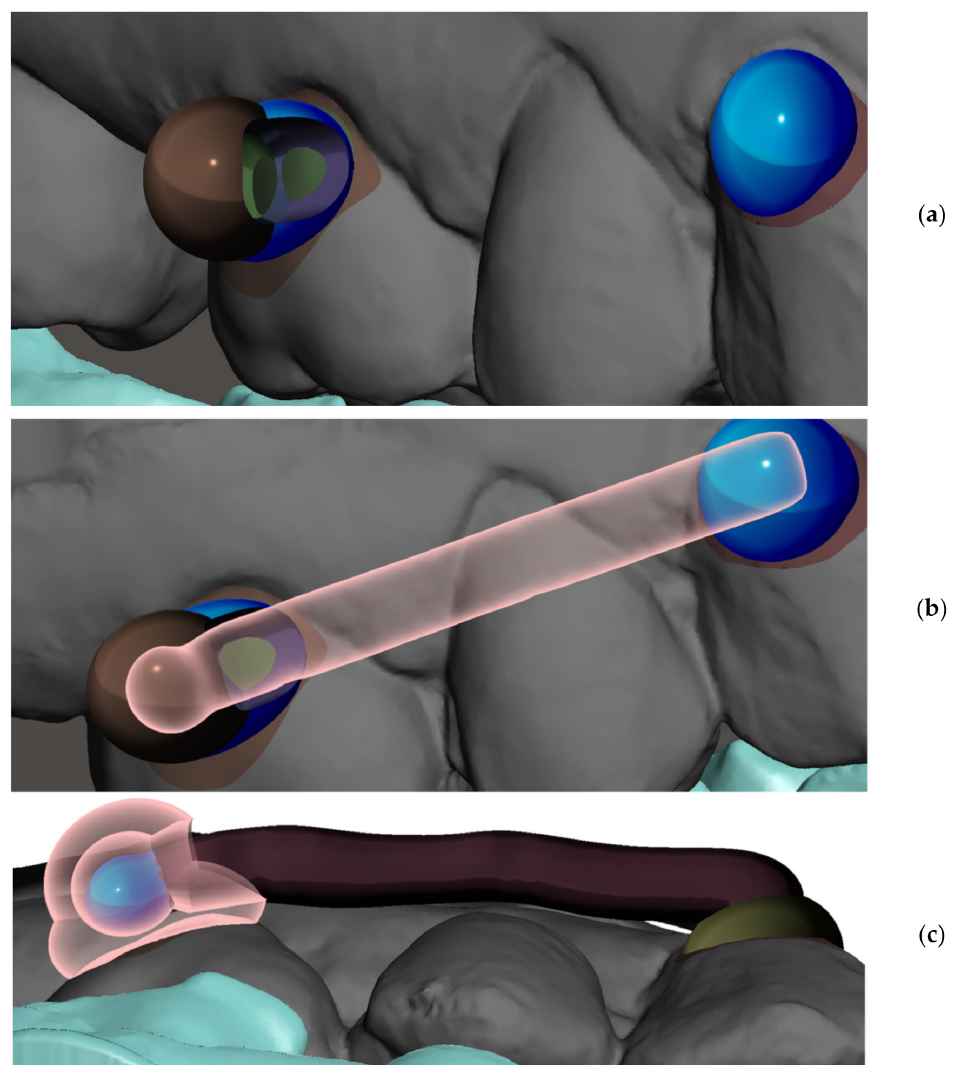
Figure 9. Visualization of the juncture of both parts of the distalizer (bigger part with the arm and joint and the smaller part with the socket). ( a ) visual of the molar part of the distalizer including the socket; ( b ) visualization of ending of the arm of the distalizer in the body of the distal part; ( c ) profile of the layers of the distalizer’s body, socket and the